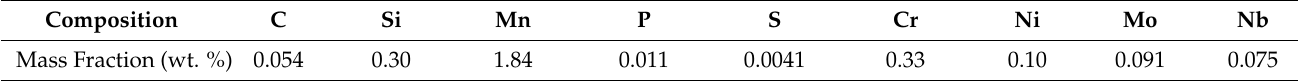
Table 1. Chemical composition of X80 steel